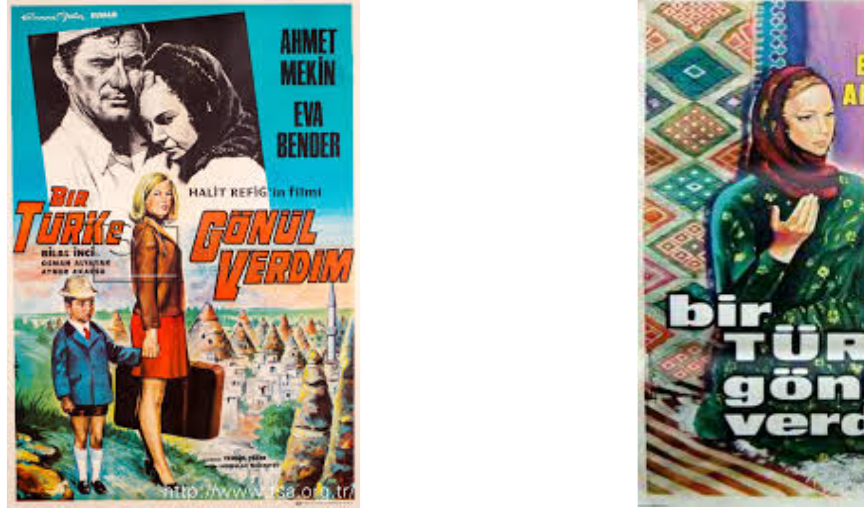
Figure 2-3: The two posters of the film I Lost My Heart to a Turk present the transformation of the German woman Eva into the Turkish woman